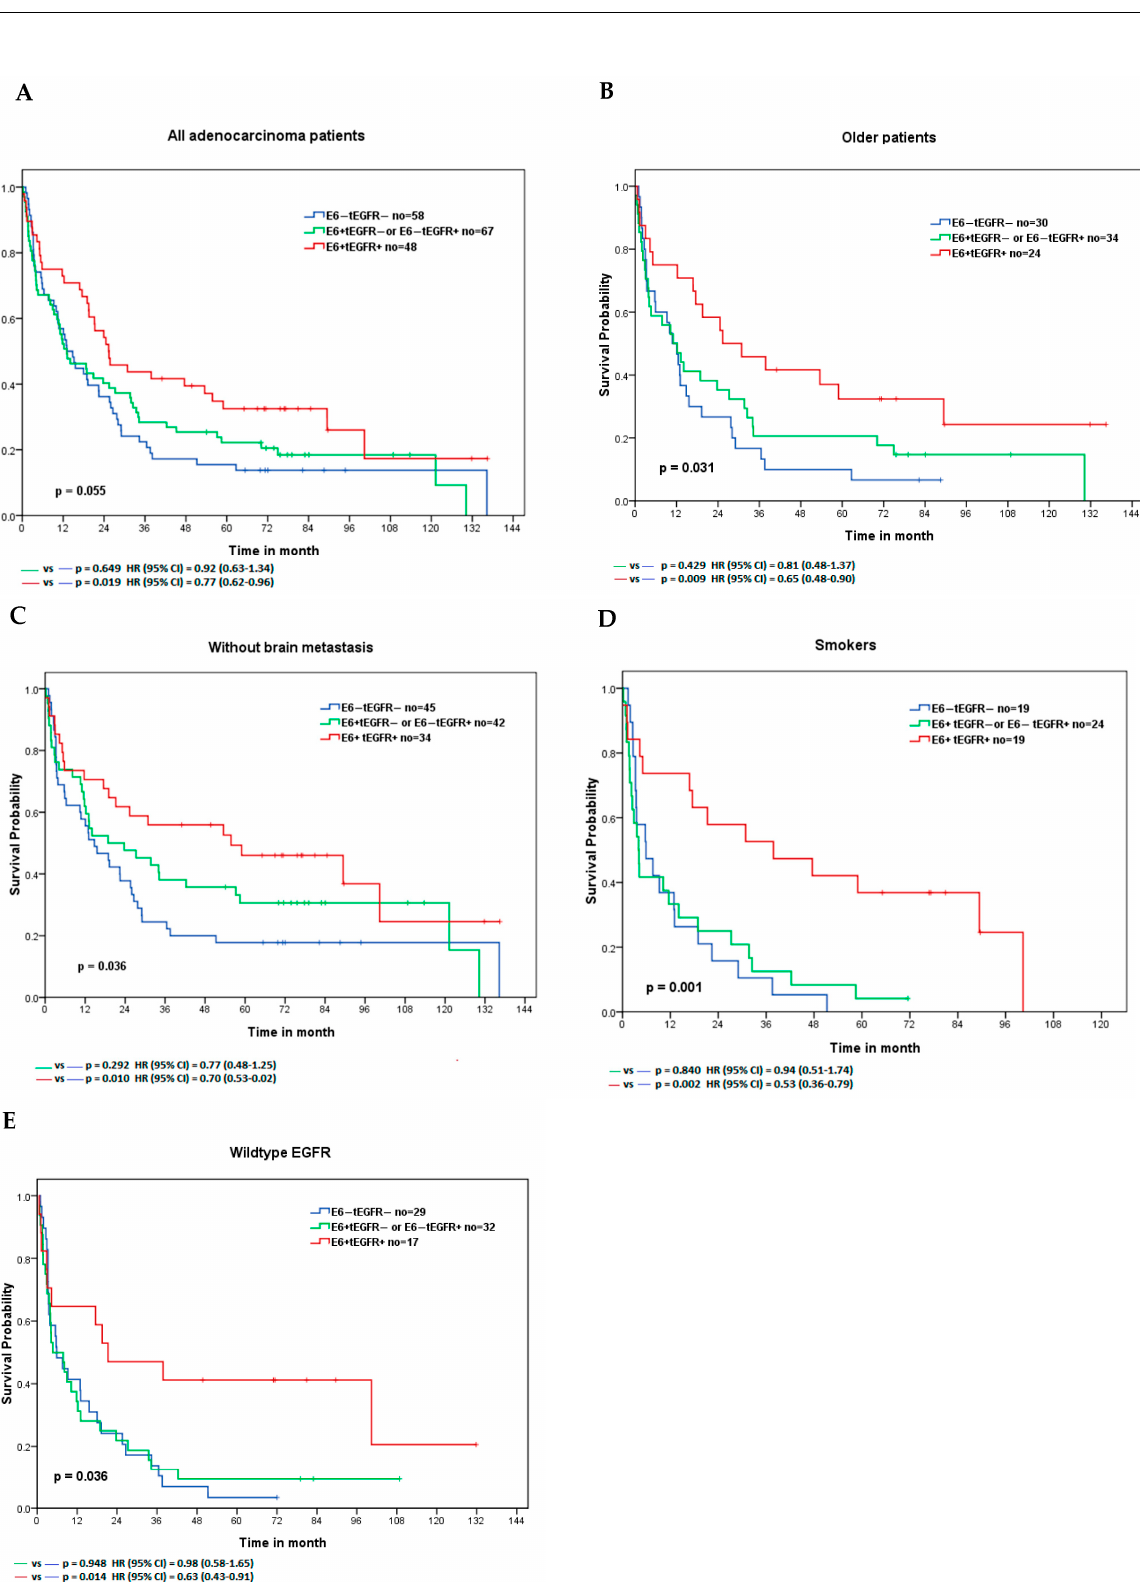
Figure 4. Survival analyses of lung adenocarcinoma patients. ( A ) For all patients; ( B ) for patients with older age; ( C ) for patients without brain metastasis; ( D ) for patients with smoking history; ( E ) for patients with wild-type epidermal growth factor receptor (EGFR) status. Table 3. Comparison of treatment response in 173 lung adenocarcinoma patients after platinum- based chemotherapy.